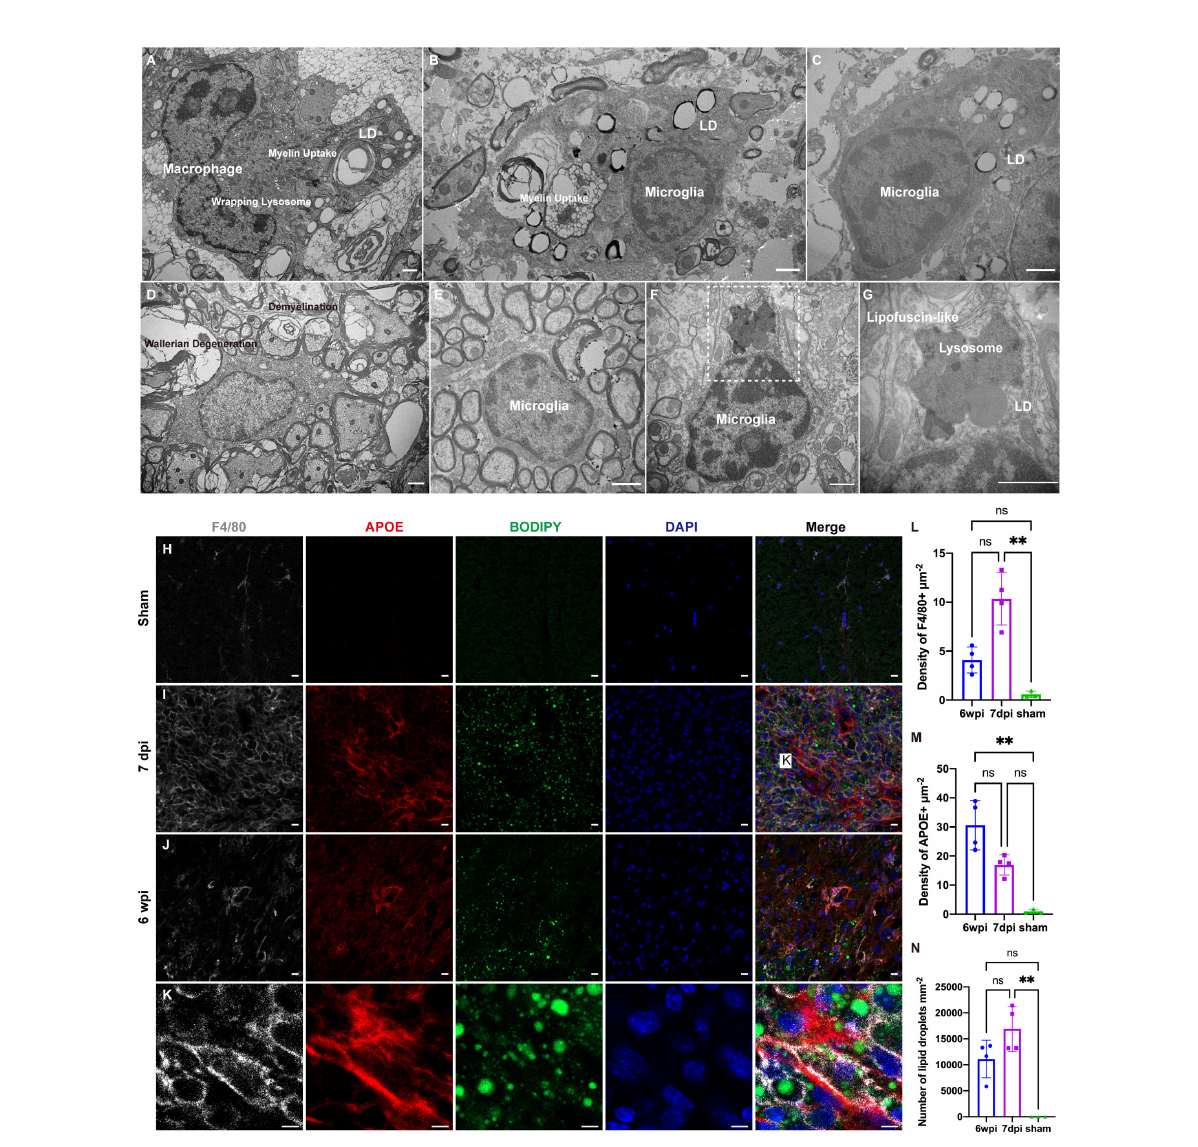
FIGURE 6 Transmission electron microscopy (TEM) analysis and immuno fl uorescence staining of a mouse model of cervical spinal cord hemi-contusion. (A) TEM image of macrophages sampled seven days post injury (dpi) showing myelin uptake, lipid droplet accumulation, and “ wrapping lysosomes ” . (B, C) Representative images of microglia sampled seven dpi showing myelin uptake, lipid droplet accumulation, and “ wrapping lysosomes ” . (D) TEM image of lesions sampled six weeks post injury (wpi) showing Wallerian degeneration and demyelination. (E) Representative image of healthy microglia in the sham group. (F, G) TEM images of microglia sampled six wpi showing lipofuscin granules and lipid droplets. The boxed area is shown in (G) at higher magni fi cation. (H – J) Immuno fl uorescence staining of spinal cord samples showing F4/80+ microglia/ macrophages (white), APOE (red), BODIPY (green) and DAPI (blue). Box is the approximate area where (K) was imaged. (K) High-magni fi cation representative images of the APOE+ macrophages/microglia containing BODIPY+ lipid droplets. (L) Quantitation of F4/80+ densities showed that F4/80+ densities were signi fi cantly increased at 7dpi. (M) Quantitation of APOE+ densities showed that APOE+ densities were signi fi cantly increased at 6 wpi. (N) Quantitation of lipid droplets showed that the number of lipid droplets were signi fi cantly increased at 7dpi. LD, lipid droplets. ns P > 0.05, **P < 0.05. Scale bar (A – G) = 1 µm. Scale bar (H – J) = 10 µm. Scale bar (K) = 5